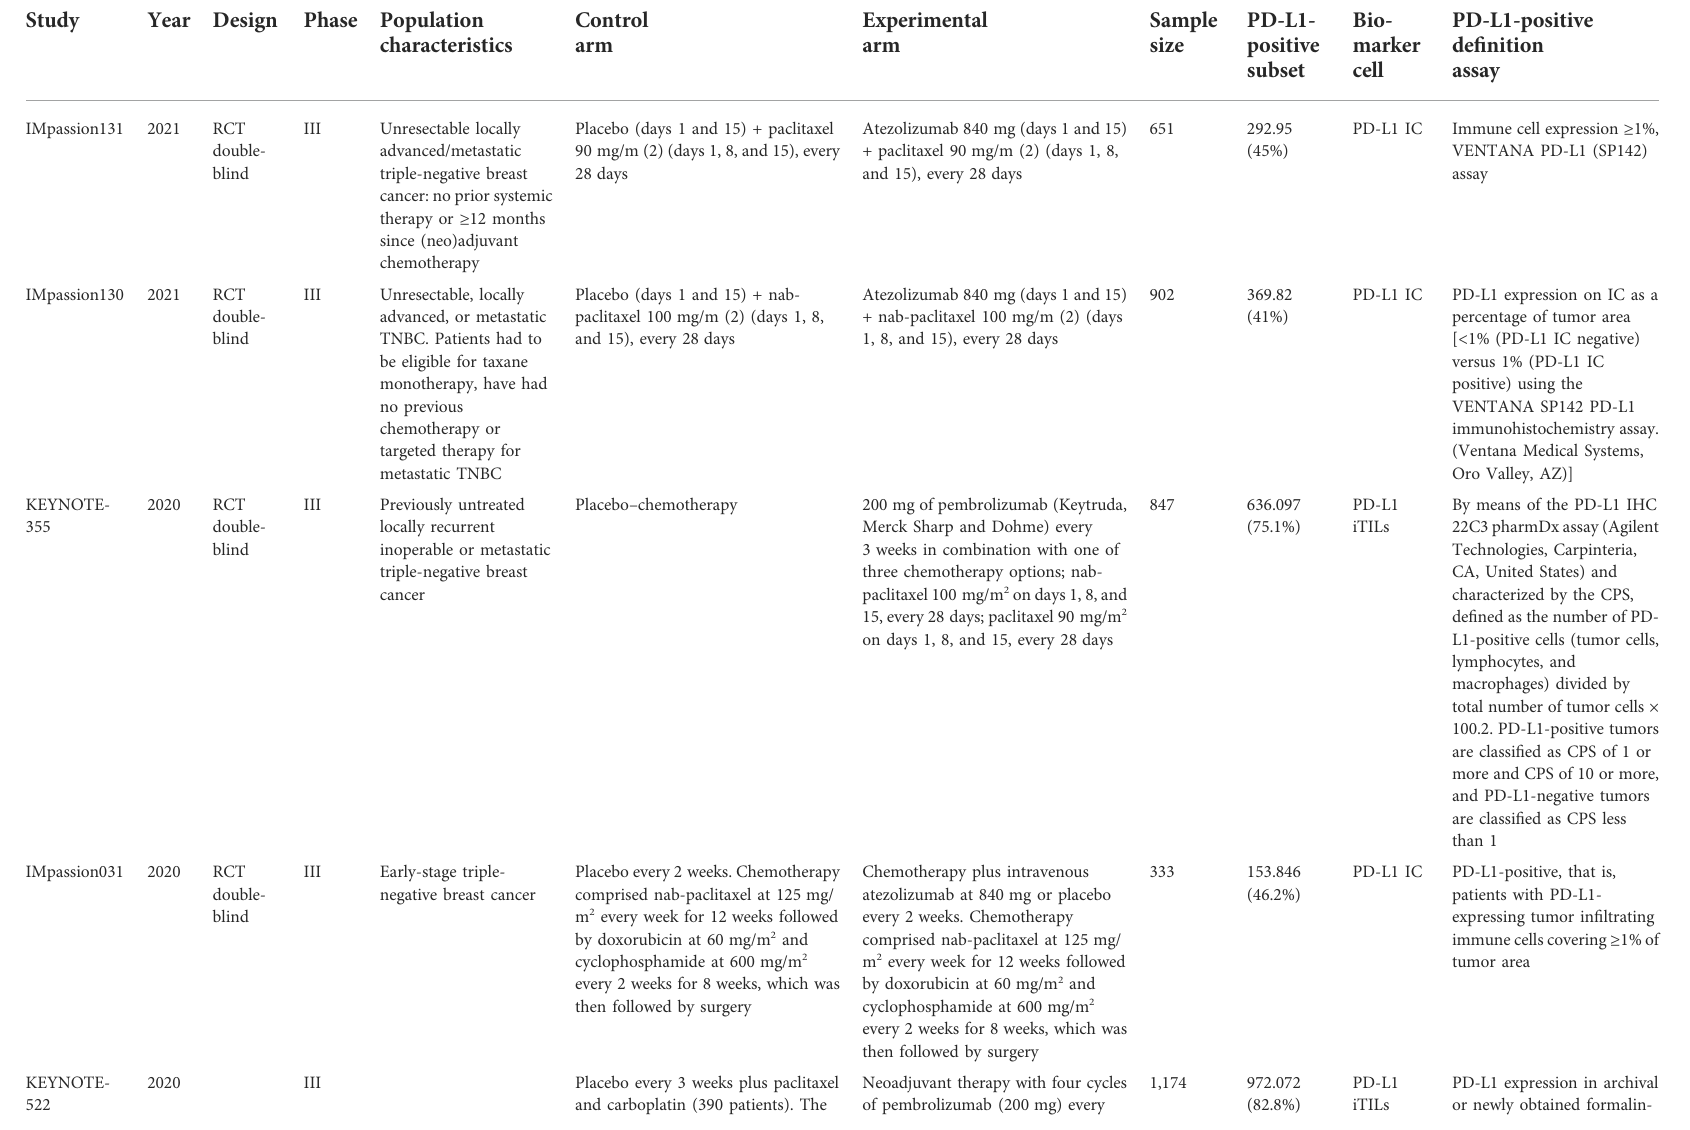
TABLE 1 Characteristics of the studies included in the